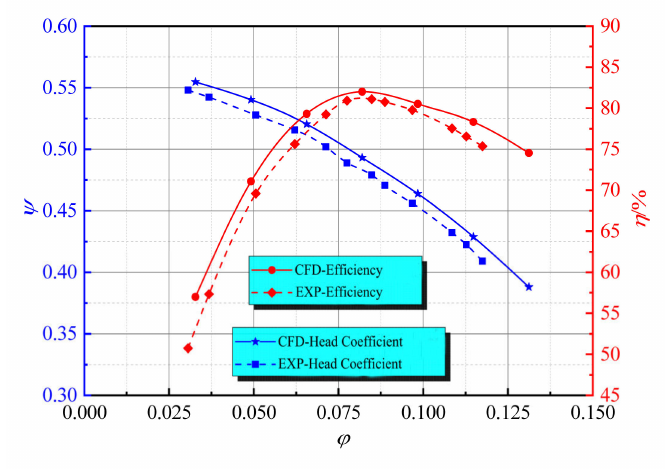
Figure 10. Comparison of the pump performance between the test and the numerical